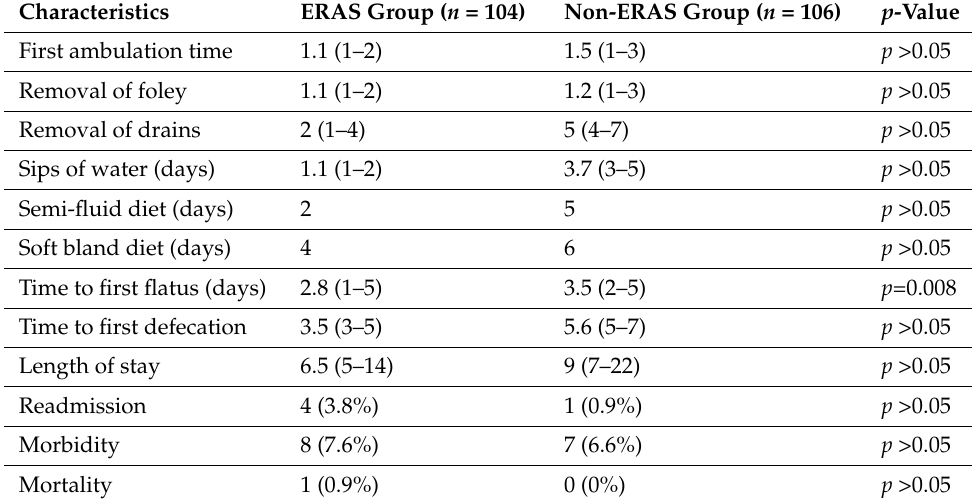
Table 3. Post-operative outcomes.